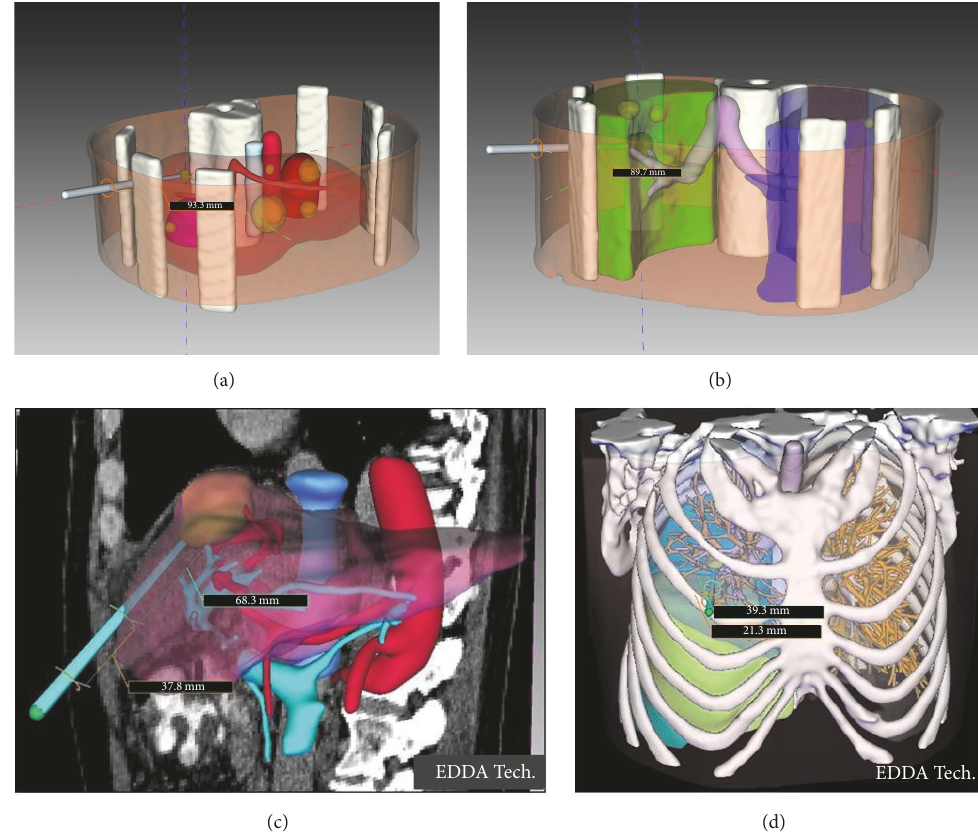
Figure 2: Fully quantified 3D anatomy generated from the CT scans with interactively planned and real-time depth. (a) Abdominal scan in phantom (b) Thoracic scan in phantom (c-d) 3D anatomic map in